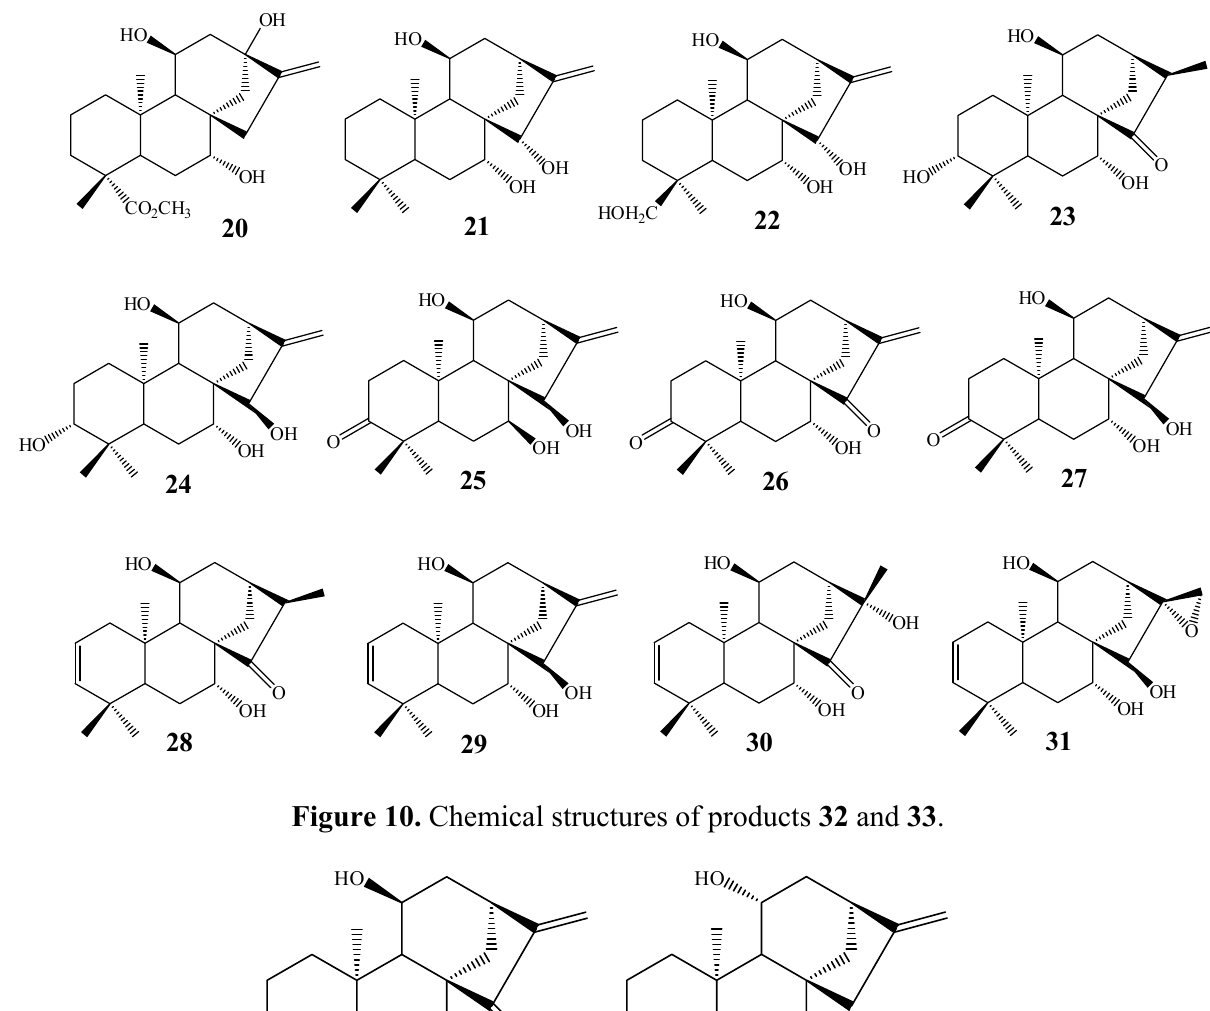
Figure 9. Chemical structures of the great structural diversity of biotransformation products hydroxylated in carbons 7 and 11 by the fungus G. fujikuroi .